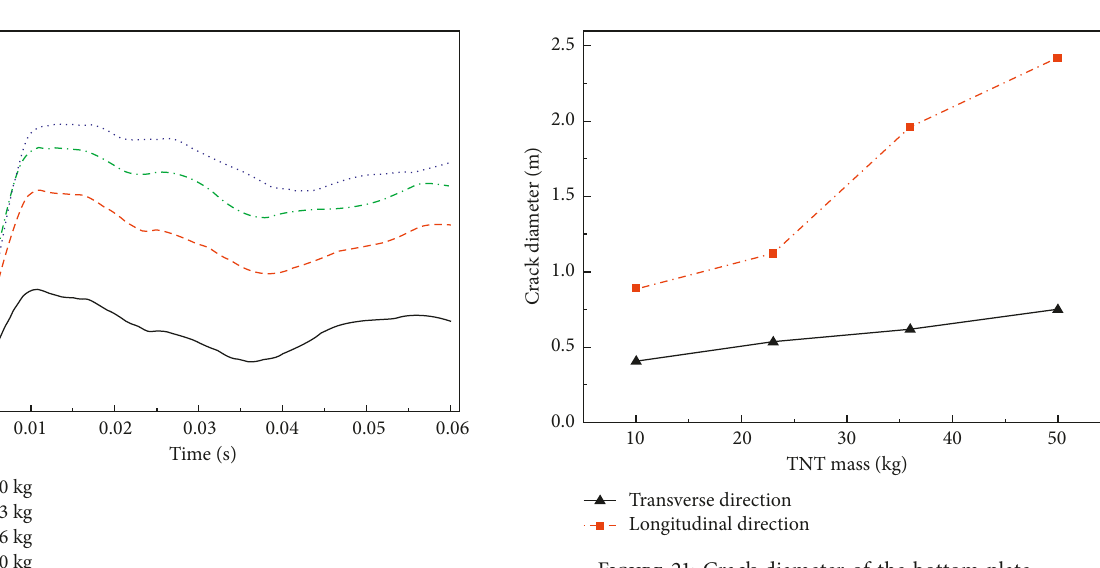
Figure 21: Crack diameter of the bottom